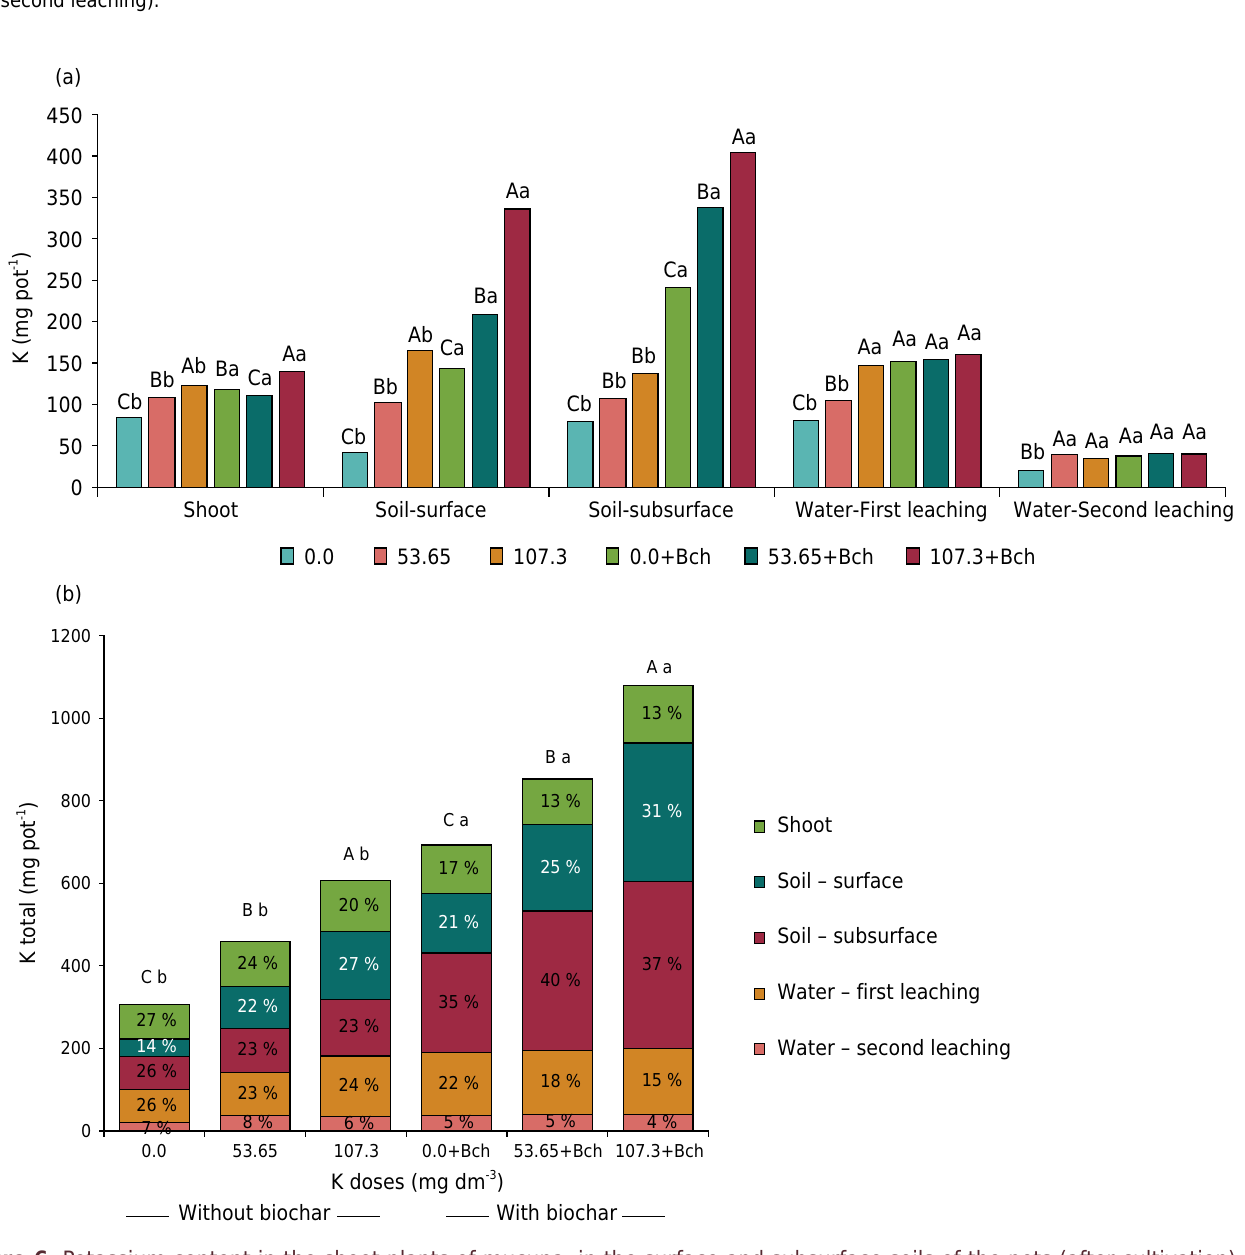
ns ns ns ns C.V. (%) 5.07 5.42 3.98 11.31 17.29 8.6